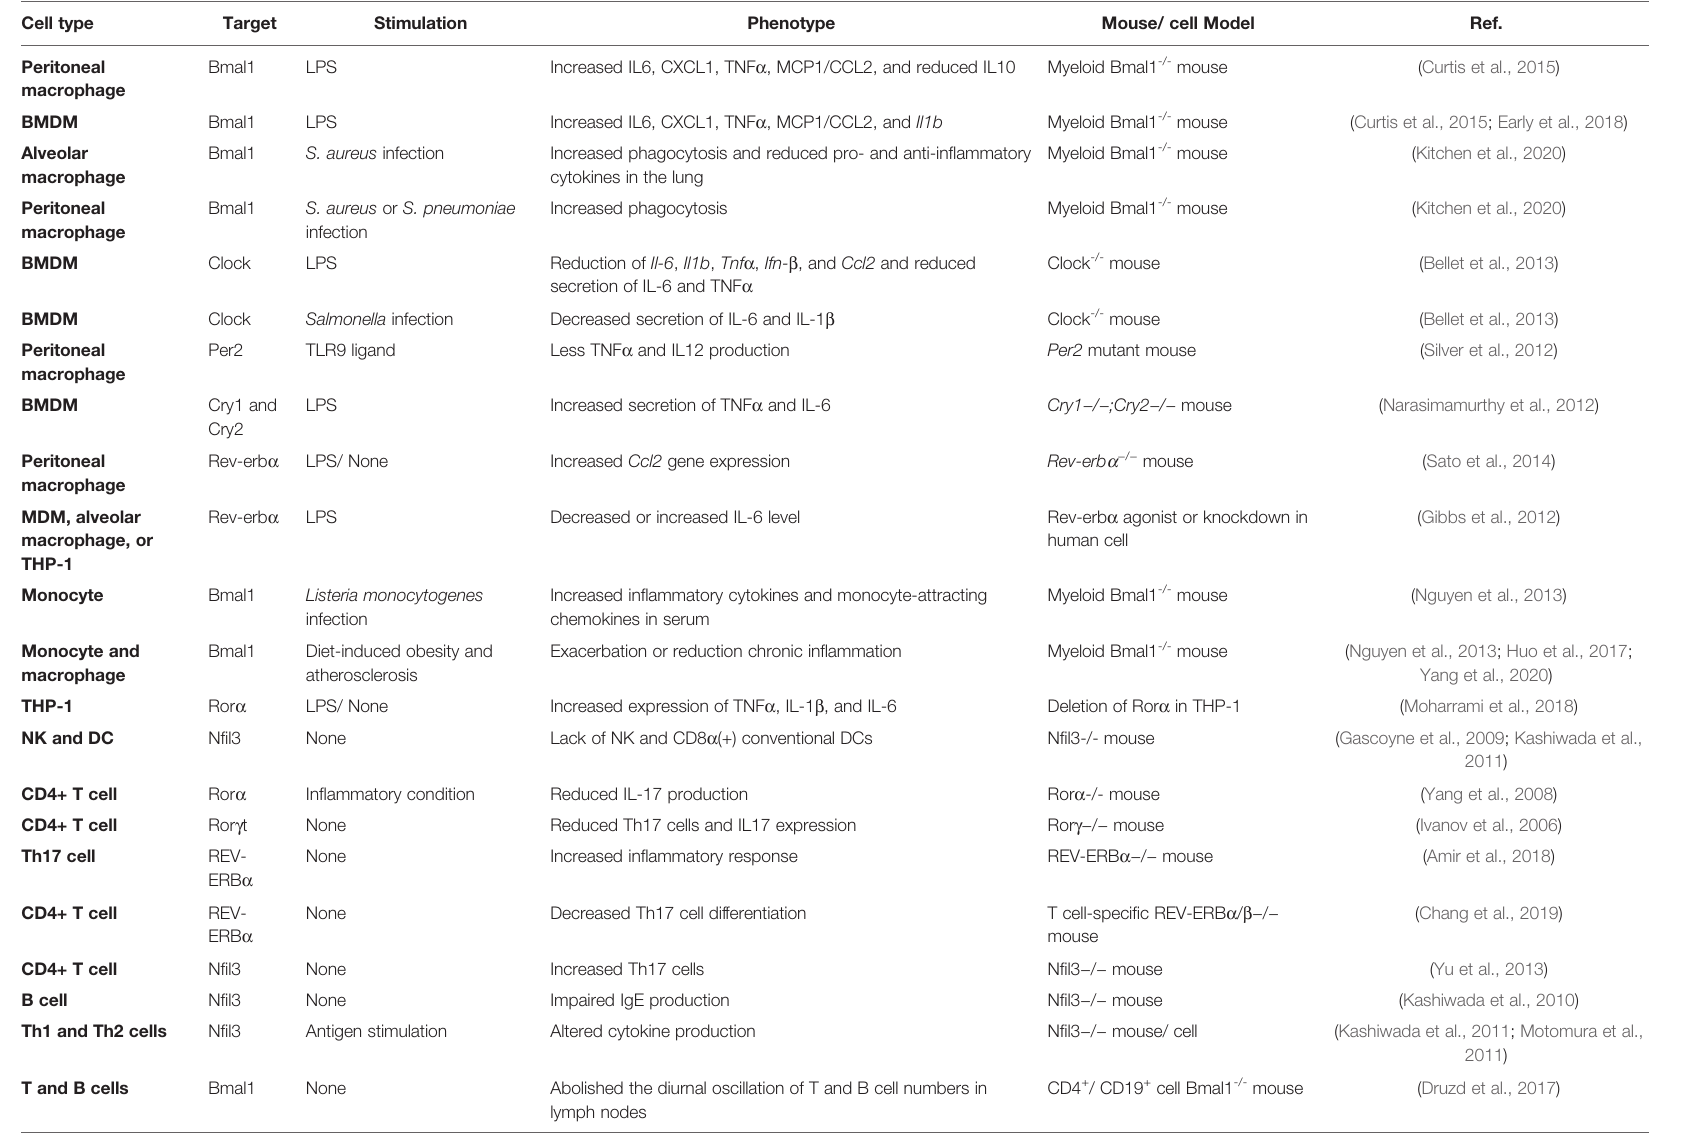
TABLE 1 | Effect of the circadian clock on peripheral innate and adaptive